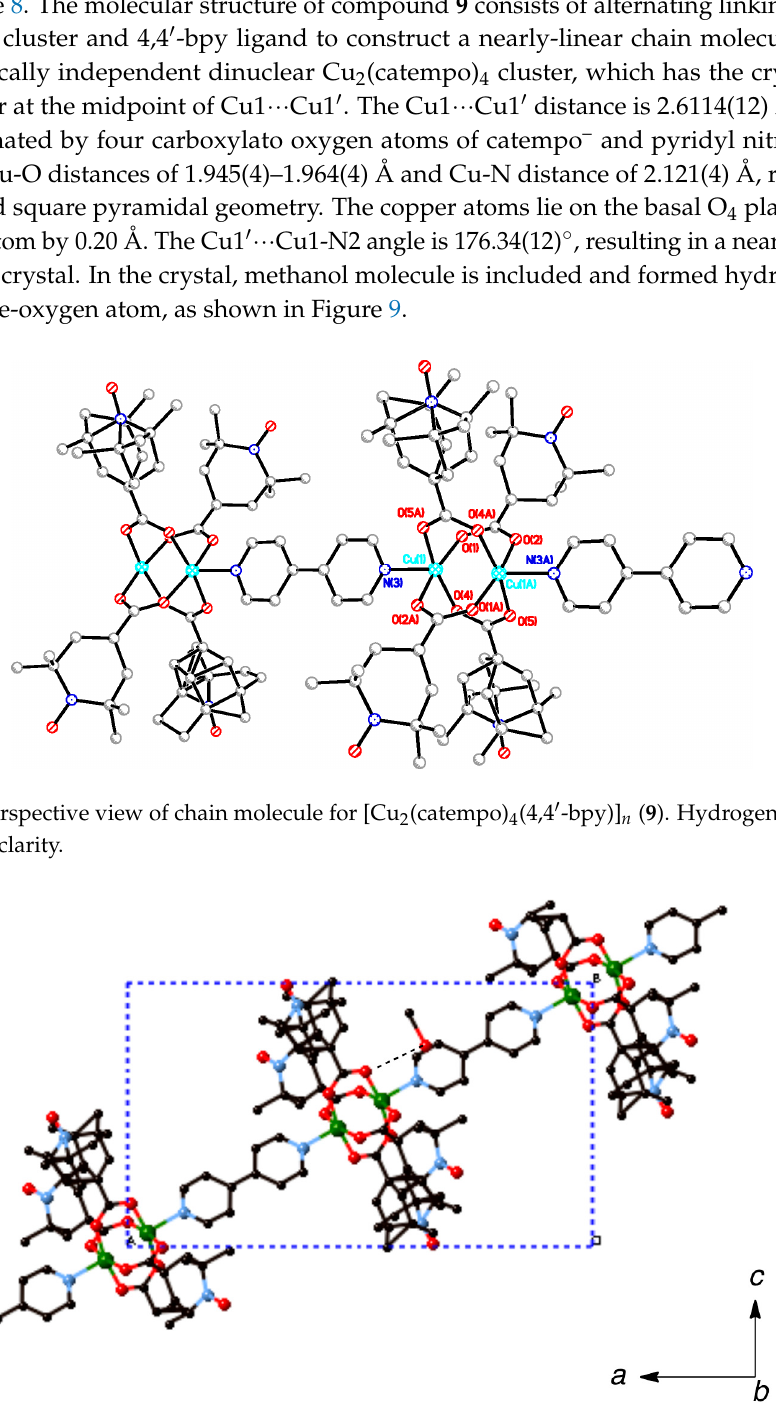
Figure 9. Packing diagram of [Cu 2 (captempo) 4 (4,4 ′ -bpy)] n ( 9 ). Hydrogen atoms are omitted for clarity. Dotted line denotes the hydrogen bonding.